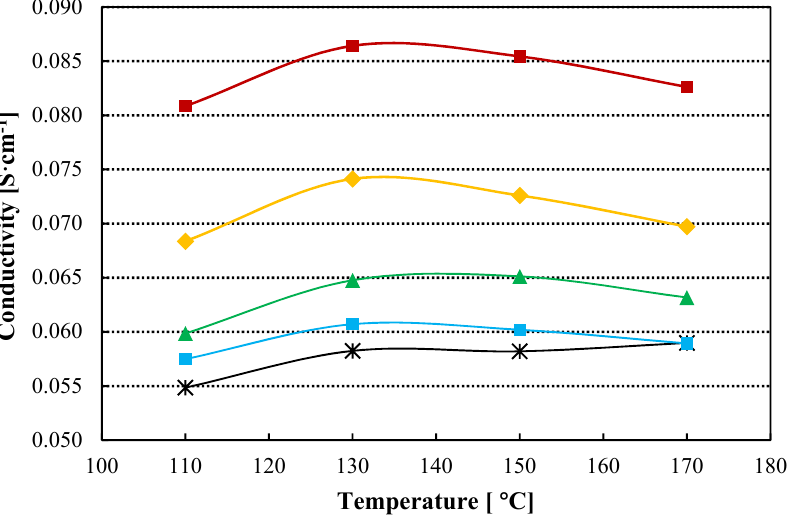
Figure 3. In plane conductivity for the prepared membranes. Doped with 85 wt% H 3 PO 4 . Black line: Std-PBI; Red line: 0.5 wt% TiO 2 -PBI; Yellow line: 1.0 wt% TiO 2 -PBI; Green line: 2.0 wt% TiO 2 -PBI; Blue line: 3.0 wt% TiO 2 -PBI .